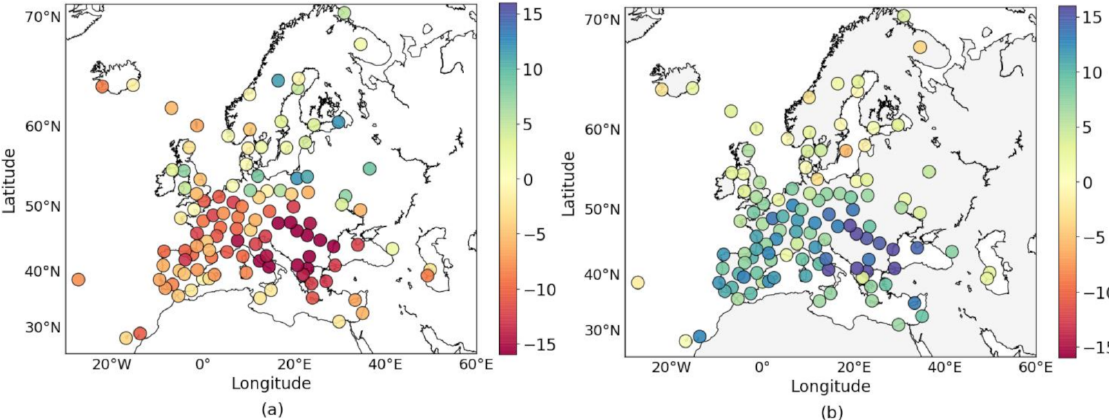
Figure 12. Spatial pattern coefficients describing the first SVD of the residuals of the TWS and those of the Up coordinate. ( a ) TWS spatial pattern; ( b ) Up spatial